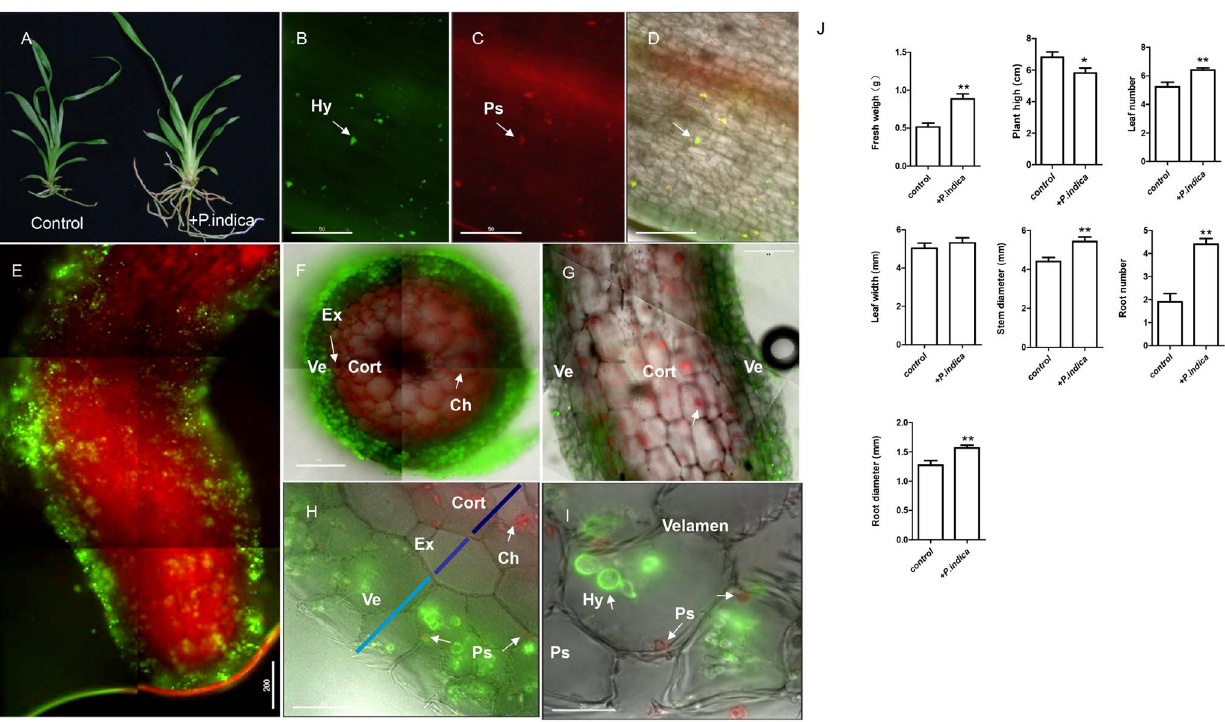
Figure 1. Growth effects of P.indica on Oncidium orchid. (A) Seedlings inoculated with P. indica for 8 weeks showed significantly enhanced growth and root development. (B–D) Anatomic structures of roots colonized by P. indica for 24 hours. Hyphae (green spots in B, arrow head) and penetration site (red spots in C, arrow head) were overlayed in bright field (D, arrow head). Bar=50 m m. (E) Microscopic structure of roots colonized by P. indica for 5 days. A large number of hyphae were widespread over the root surface and tip, elongation zone and mature zone. Bar=200 m m. (F, G) Microscopic structures of transverse sections and longitudinal sections of roots colonized by P.indica for 5 days. Hyphae fully colonized the velamen. Chloroplast autofluorescence (red) was also detected in cortex. Bar=200 m m. (H) Microscopic structures of transverse section of roots colonized by P. indica for 5 days. P. indica was restricted in the velamen and not detectable in the exodermis of Oncidium roots. Chloroplast autofluorescence (red) was detected in cortex. Bar=50 m m. (I) Micrograph of root cross sections from seedlings colonized with P. indica for 5 days. Without chlorophyll fluorescence in velamen, the penetration sites (red spot) were clearly detected. Bar=20 m m. (J) Growth quantification of seedling colonized with P. indica for 8 weeks. Fresh weight, plant height, leaf number, leaf wide, stem diameter, root number and diameter were analyzed. Error bars represent SD for three independent experiments. *, P value , 0.05; **, P , 0.001. Hyphae were stained with chitin-specific WGA-AF488 (green). Penetrated sites (Ps) were stained with lectin-specific conA-AF633 (red) [88]. Samples were analyzed and photographed with an Olympus IX71 inverted microscope system (Japan). Ve, velamen; EX, exodermis; Cort: cortex; Ch: Chloroplast. Hy, hyphae; Ps, penetration site.